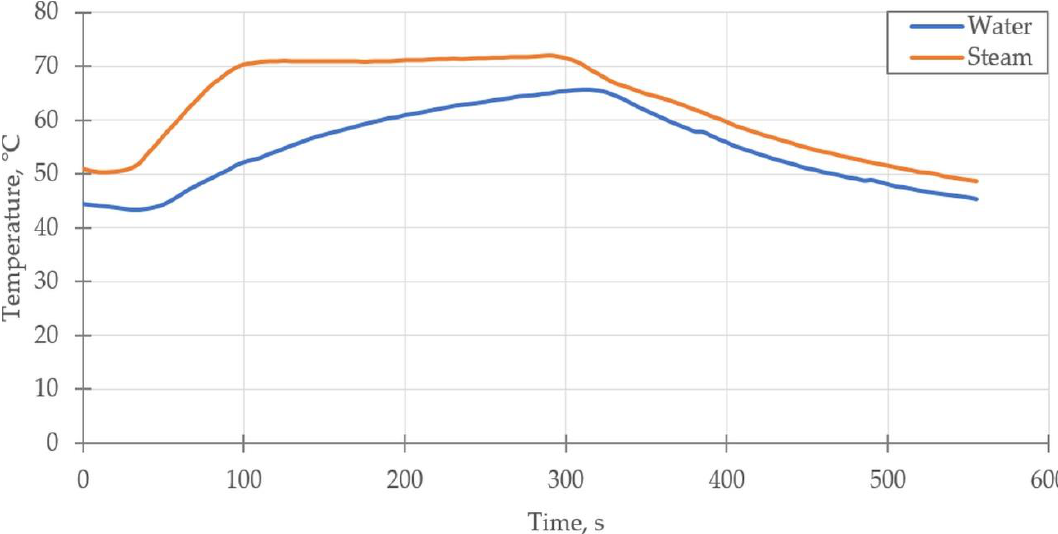
Figure 6. Temperature inside the heat exchanger (T8).